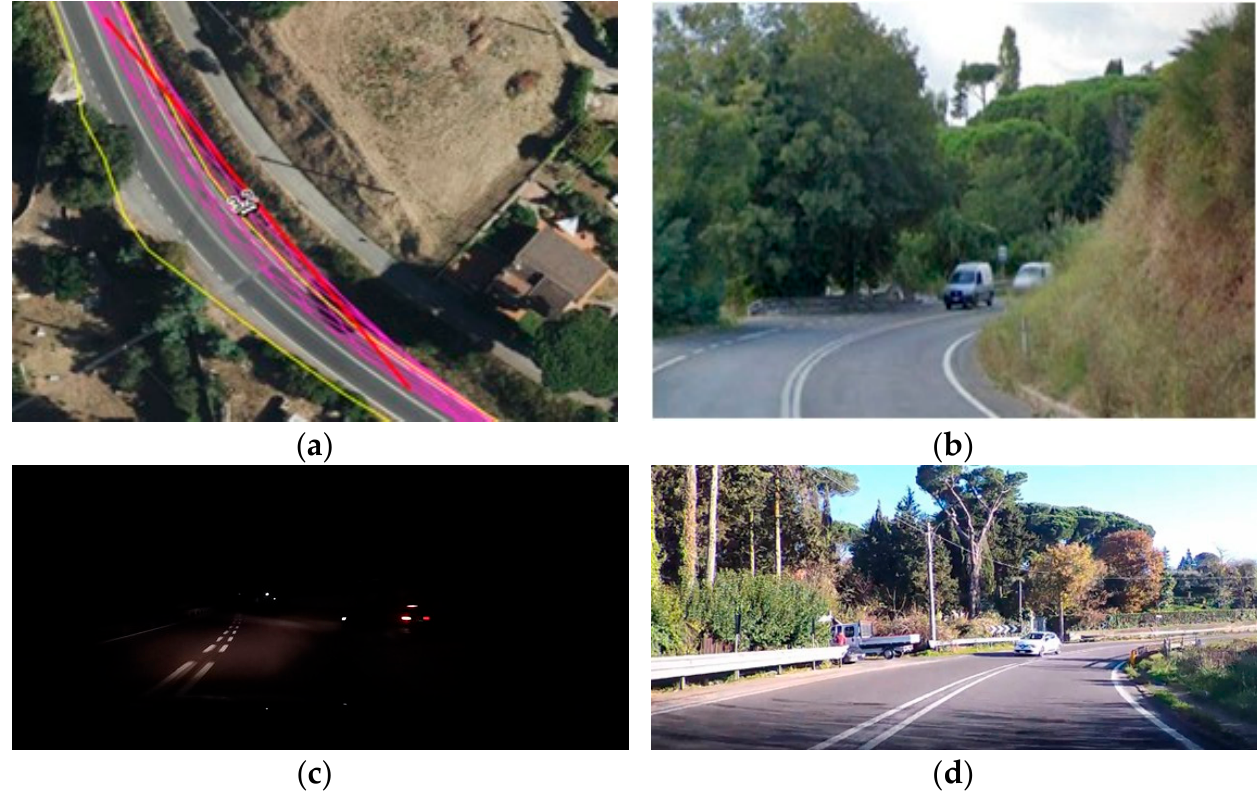
Figure 8. Examples of issues found along the road: ( a , b ) poor visibility in curves, ( c ) problems with road markings visibility at night times, and ( d ) problems related to frequent interruptions of safety devices, inadequate terminals, and repeated accesses on curves.